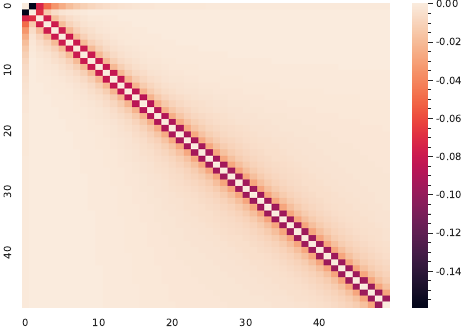
(d) Pearson correlation coefficient with sub- tracted diagonal elements.